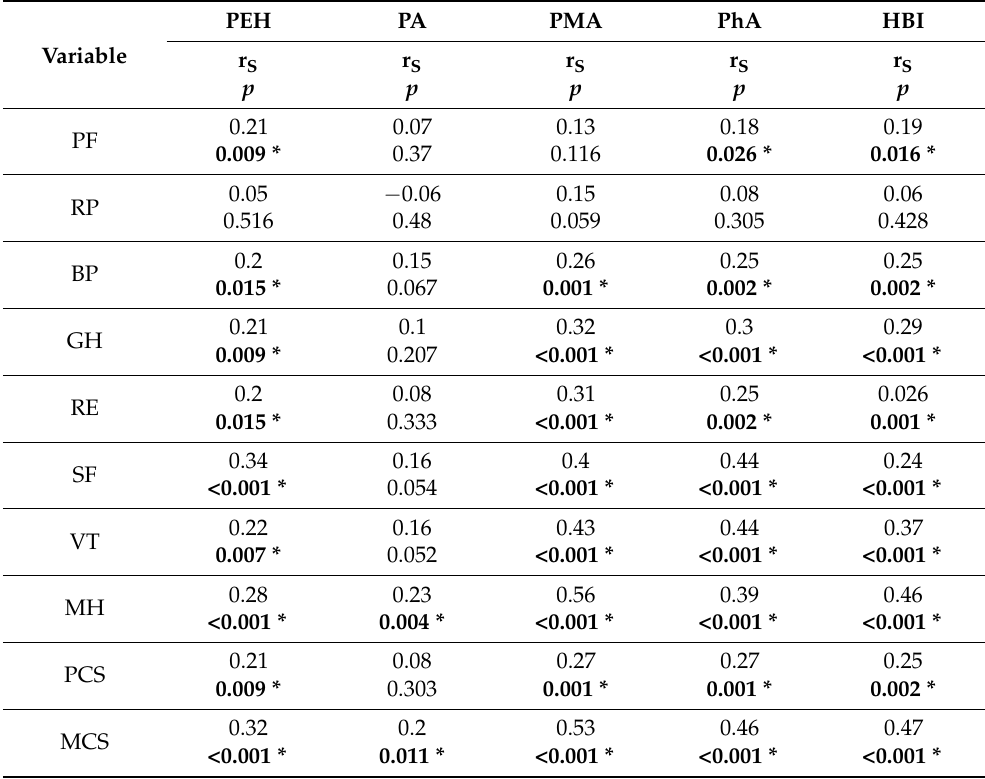
Table 2. Correlations of health behavior inventory with health-related quality of life in female respondents.